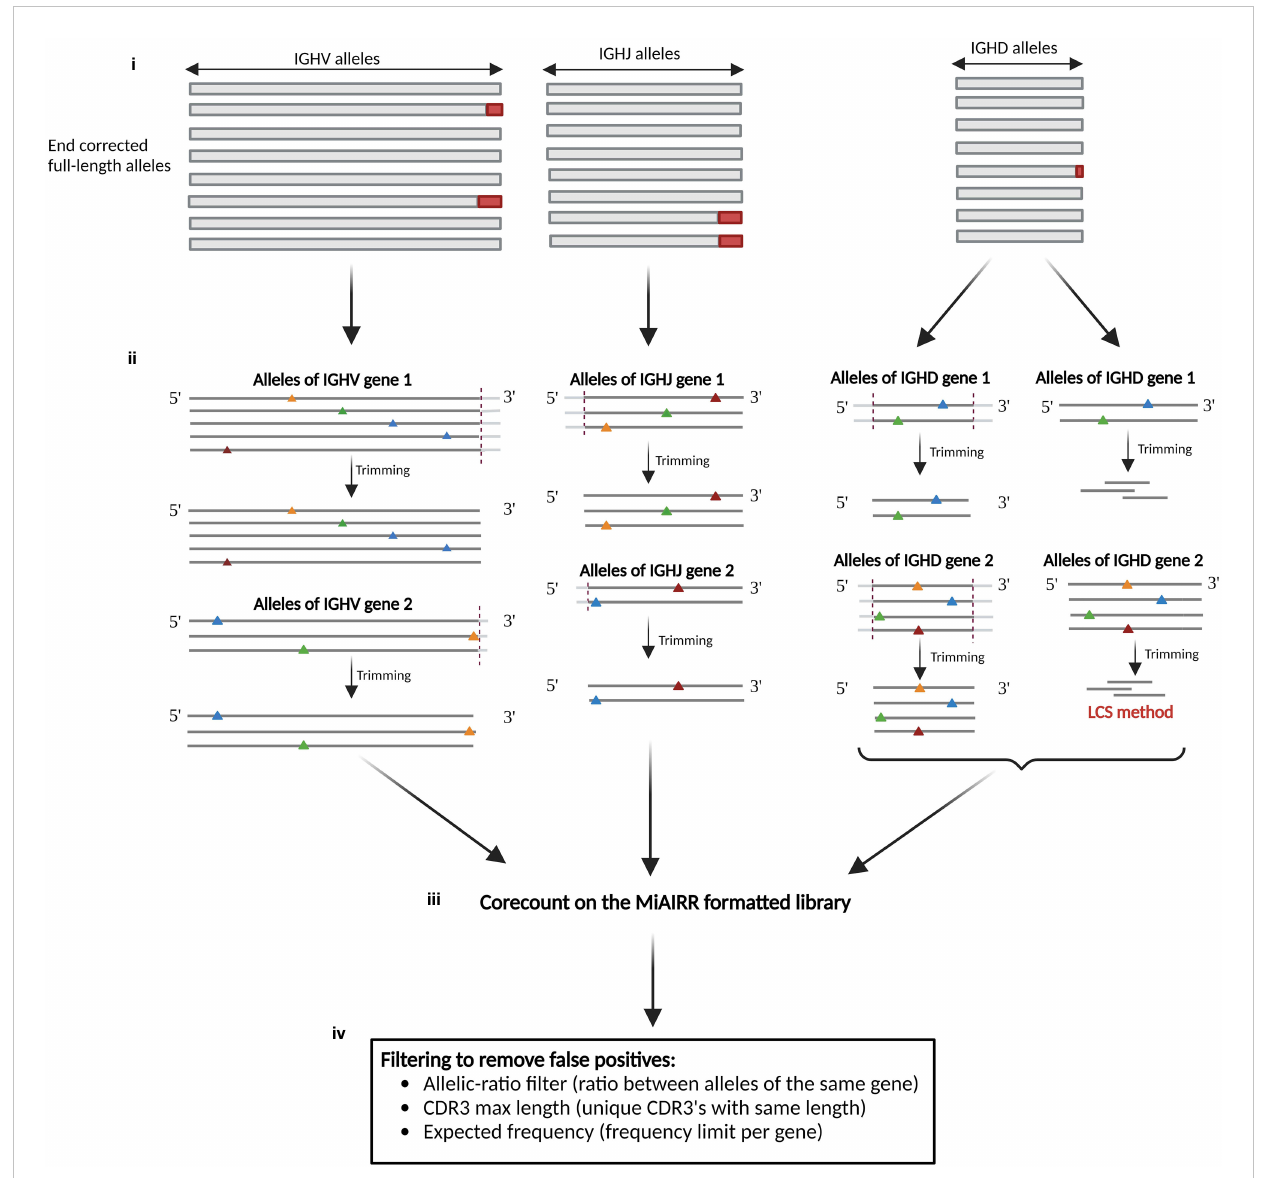
FIGURE 4 Schematic of corecount process. (i) The starting point for corecount analysis is the availability of a validated comprehensive database that contains end corrected allelic sequences. (ii) Database processing by corecount . The program processes allelic variants on a per gene basis, truncating the database sequences at the appropriate regions affected by VDJ recombination associated variation, trimming a default or user de fi ned number of nucleotides from each sequence in the recombination associated regions, to leave a ‘ core ’ sequence speci fi c for each allele. In the case of V genes where one or more allelic variant that distinguishes this allele from another is present within the last three nucleotides of the 3 ’ end of the gene, corecount truncates the sequence of all alleles of this gene only as far as that variant nucleotide. In each case, within a single gene all corecount processed alleles will be truncated by the same amount, facilitating a direct comparison of the counts for each expressed allele. The corecount database truncation occurs at the 3 ’ end of V sequences, 5 ’ end of J sequences, and both 5 ’ and 3 ’ end of D sequences. For D gene analysis, corecount additionally includes an alternative procedure that involves identifying the longest common substring (LCS) of allele speci fi c sequences within the D gene sequences that are used as alternative core sequence search strings. (iii) corecount analysis of MiAIRR formatted NGS library.